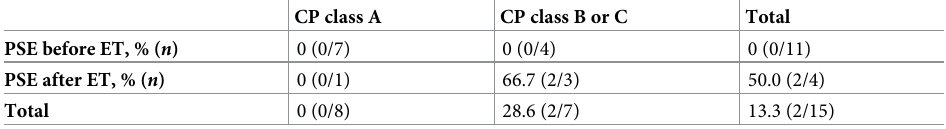
Table 3. Overall posttreatment recurrence rates of esophageal varices according to the timing of partial splenic embolization and the pretreatment Child-Pugh classification ( n =